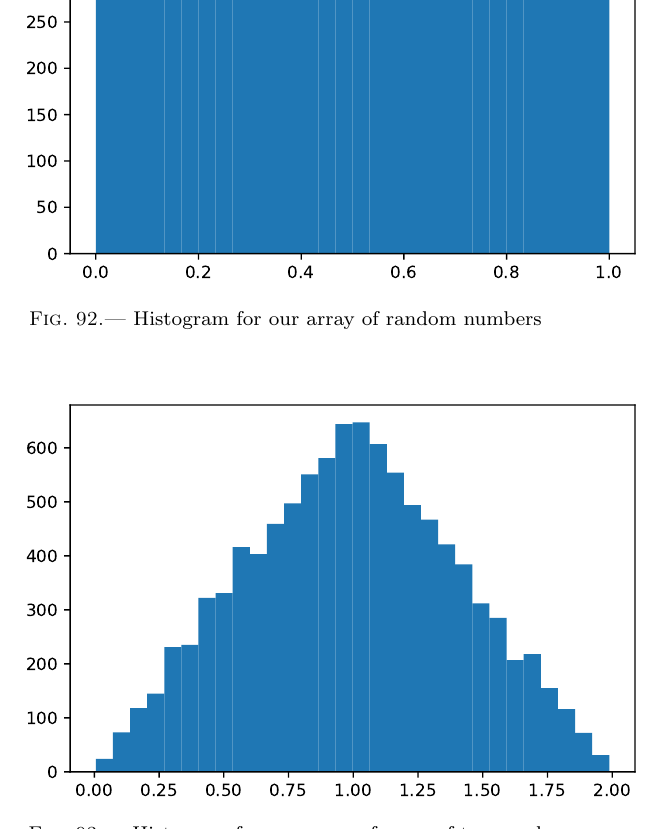
Fig. 93.— Histogram for our array of sums of two random num- bers